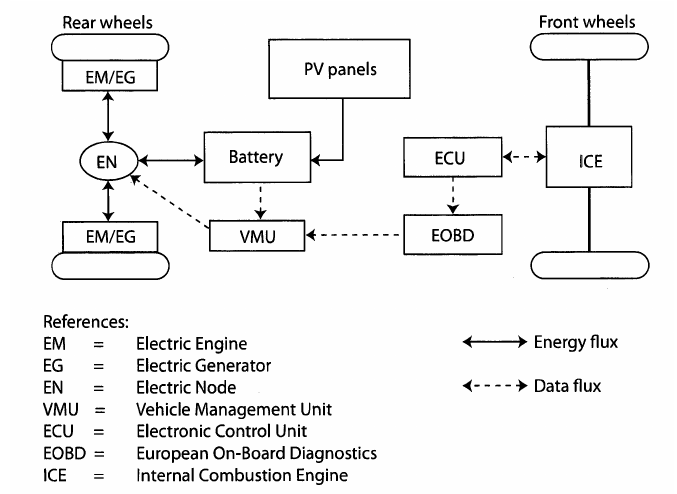
Figure 12. Block diagram of a vehicle modified by the system according to [61].